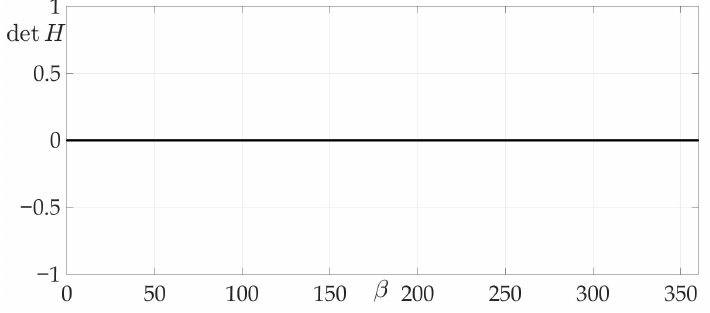
Figure 13. Dependence of Hessian det H from β .